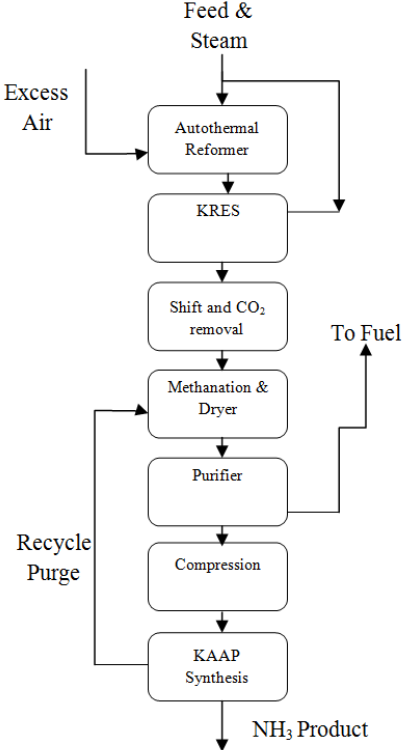
Figure 9. The KAAPplus concept, reproduced from References